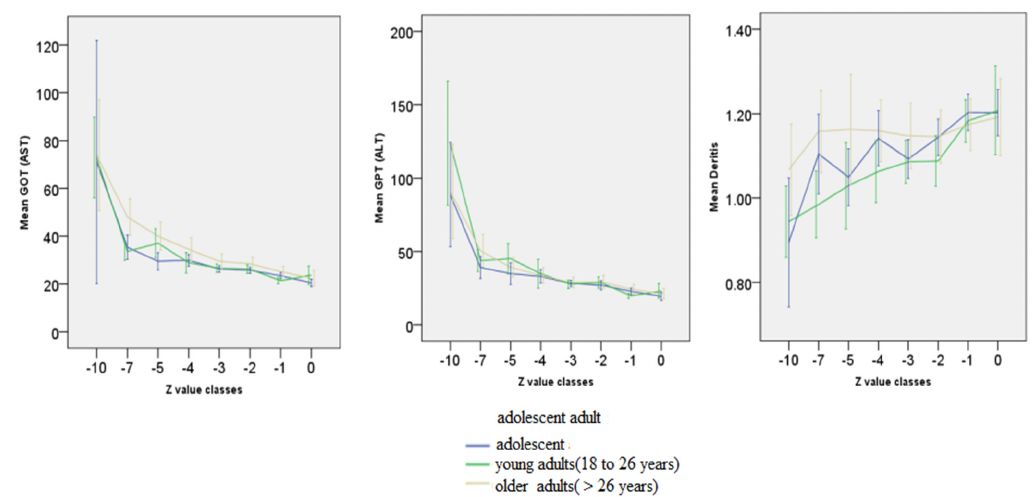
Figure 2. Age-specific N see Table 2—Relationship between BMI and GOT (AST), GPT (ALT) and de Ritis quotient (GOT/GPT) depending on age. Adolescent < 18 y; young adults 18 to 16 y; older adult > 26 y. Z-transformation of BMI using the CDC’s LMS table. Error bars represent 95% confidence interval. gained weight rapidly, especially in the first week (most likely due to hypovolaemia on